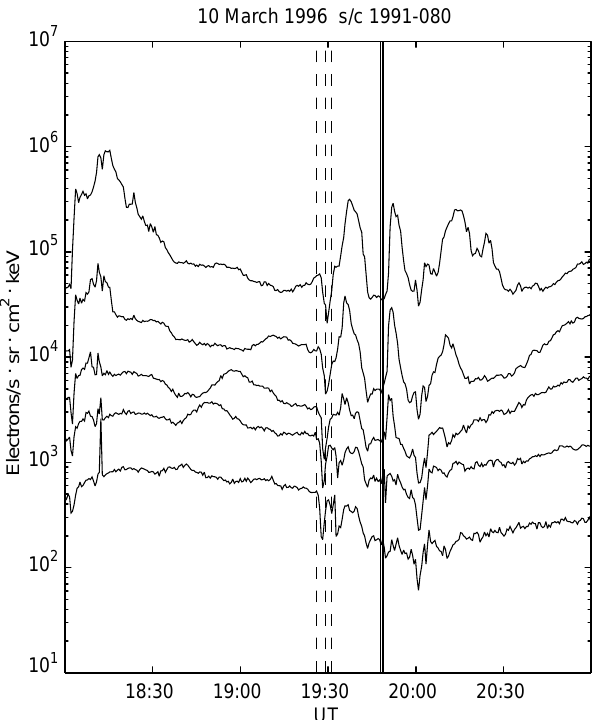
Fig. 11. The fading event on 10 March 1996: di(cid:128)erential electron fluxes recorded by the geostationary satellite 1991-080. The vertical solid lines mark the fadings and the breakup time, and the fadings before the pseudo-breakup are marked with the dashed lines . The energy channels are (from top to bottom) 50–75, 75–105, 105–150, 150–225, and